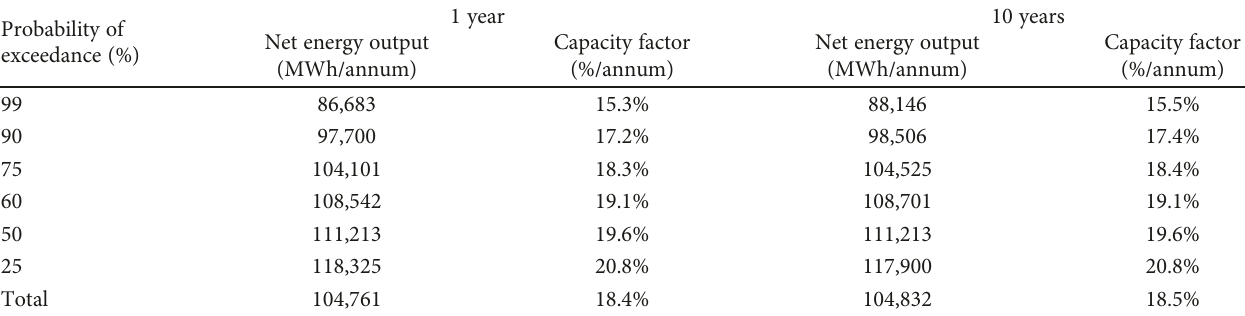
Table 11: Con fi dence limits for the PV layout of PV plant 1- and 10-year periods, without power degradation.